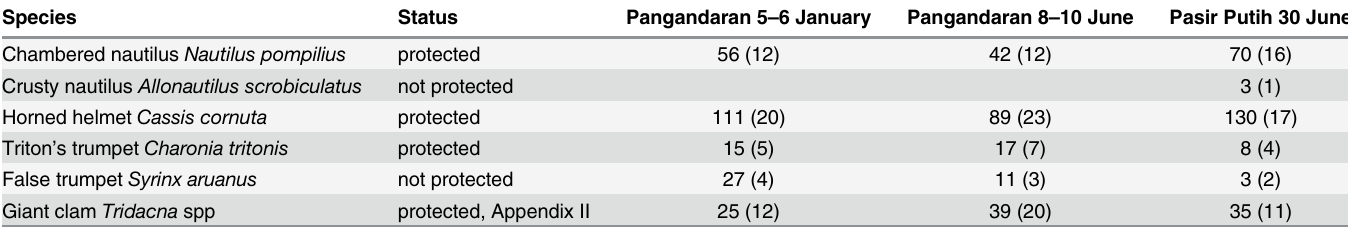
Table 1. Protected shells for sale in Java. Trade in marine shells at Pangandaran and Pasir Putih beach resorts, Java, Indonesia, in January and June 2013, with between brackets the number of stalls where the species was offered for sale. Status: protected = protected under Indonesian law since 1987, Appendix II = included on Appendix II of the Convention on International Trade in Endangered Species of Fauna and Flora (CITES) since 1983, regulating all international trade.